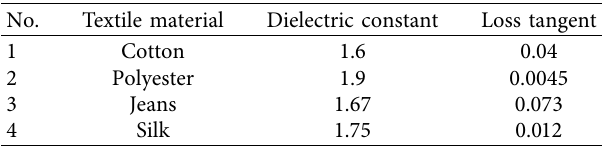
Figure 6: The 3D gain of the optimized antenna at all five resonance frequencies: (a) 27.8GHz, (b) 30.3GHz, (c) 40.1GHz, (d) 47.2GHz, and (e) 56.7GHz. Table 2: The dielectric constant and the loss tangent value of the selected fabric